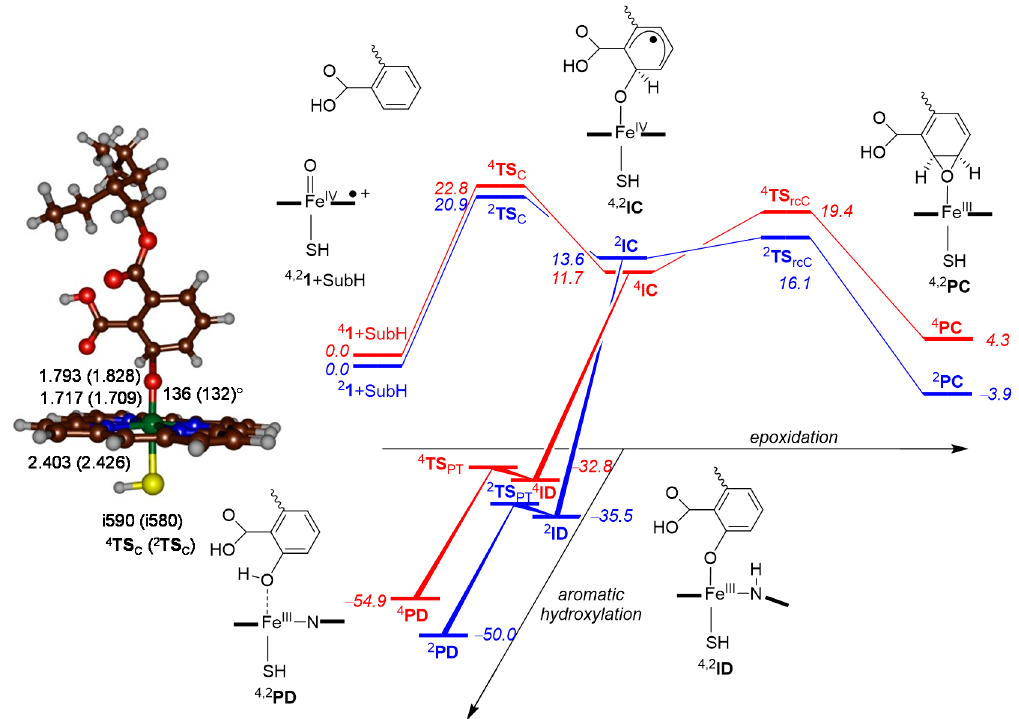
Figure 7. Potential energy landscape (B3LYP/BS1 optimized) of epoxidation and aromatic hydroxylation of phthalate by P450 CpdI. Relative energies contain zero-point corrections and are taken from B3LYP/BS2//B3LYP/BS1 in kcal·mol − 1 . Optimized geometries give bond lengths in angstroms, the Fe–O–C angle in degrees and the imaginary frequency in the transition state in cm − 1 .